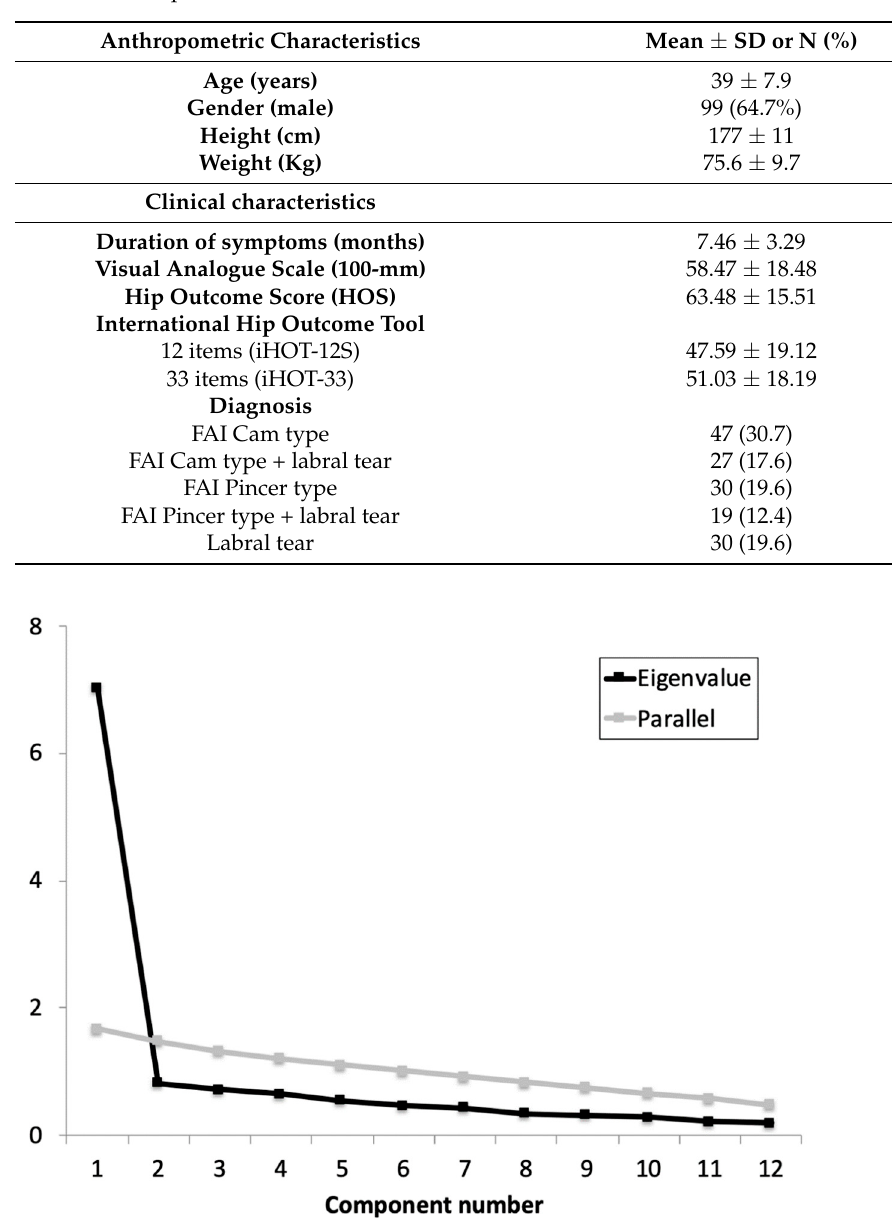
Table 1. Anthropometric and clinical characteristics.